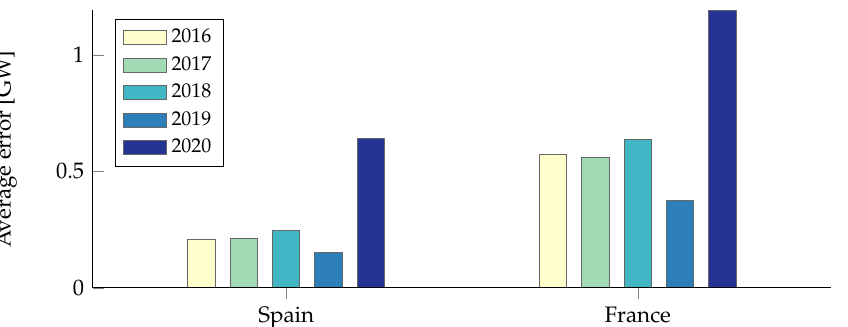
Figure 6. Average daily load forecasting error in Spain and France, between 15 March and 15 April, 2016–2020.